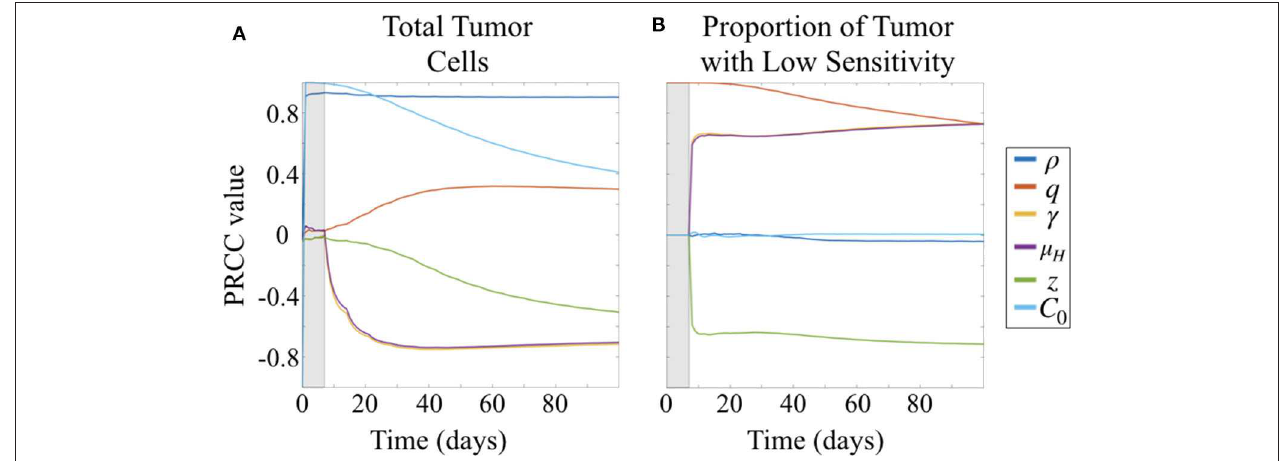
FIGURE 4 | Partial rank correlation coefficients (PRCC) of parameters with respect to (A) tumor cells and (B) fraction of cells with low sensitivity ( L / ( H + L ) = L / C ), visualized across simulation